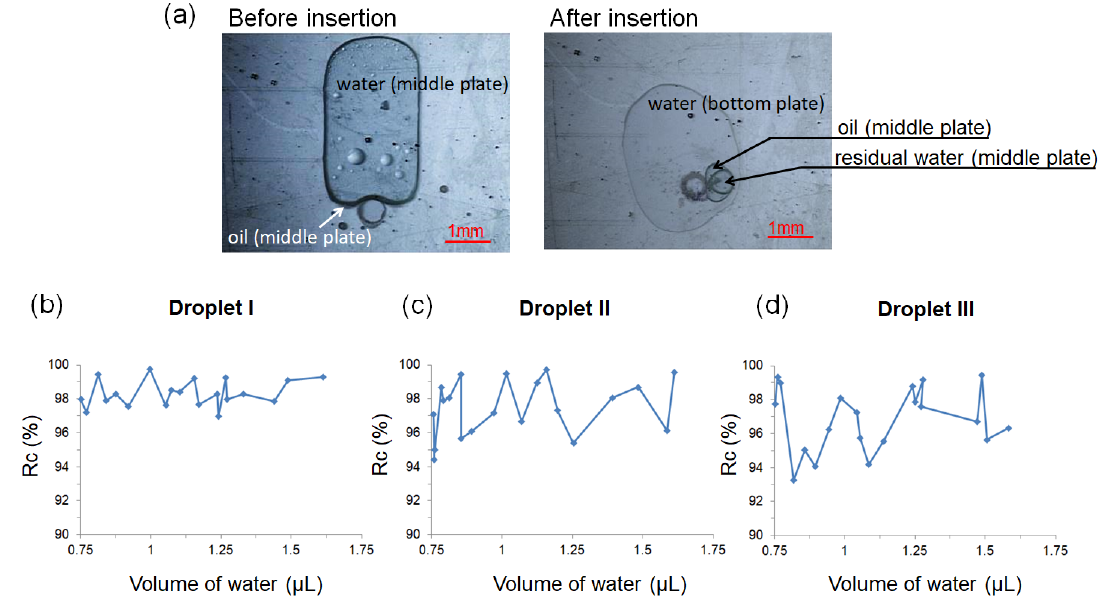
Figure 6. ( a ) Images of Droplet III before and after insertion. After insertion, residual water and most of the oil remained on the middle plate, while the majority of the water was on the bottom plate. ( b – d ) The recovery volume ratio of the core droplets for ( b ) Droplet I (water in air), ( c ) Droplet II (water – oil core – shell), and ( d ) Droplet III ((water + surfactant) – oil core – shell).